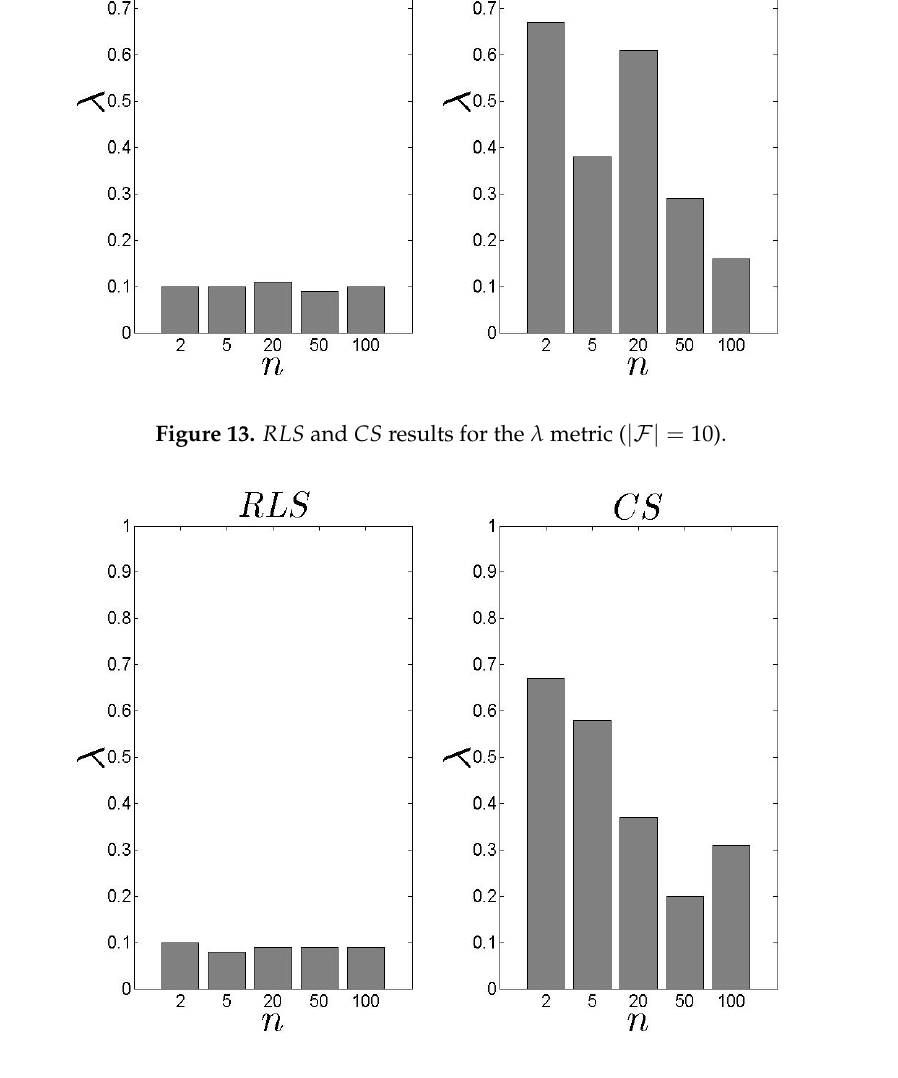
Figure 14. RLS and CS results for the λ metric ( |F| =